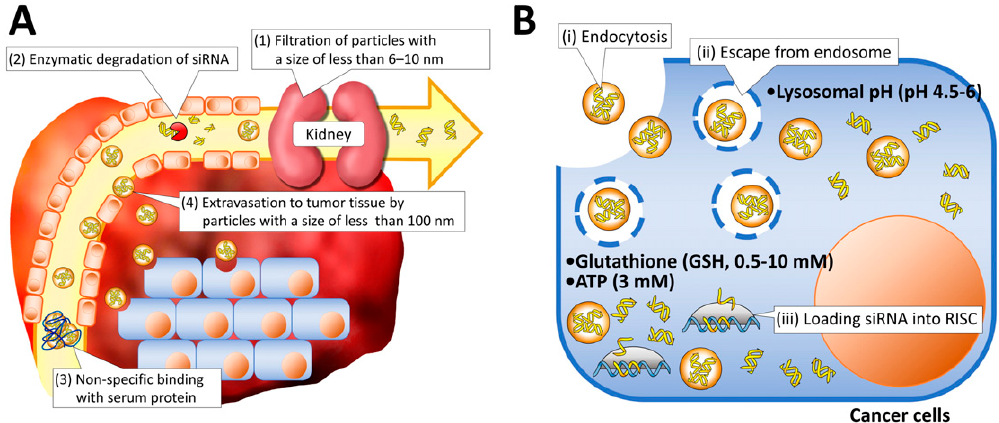
Figure 3. Schematic illustration of delivery barriers in extracellular ( A ) and intracellular ( B ) regions (Reproduced with permission from [18]. Copyright Elsevier, 2016.).